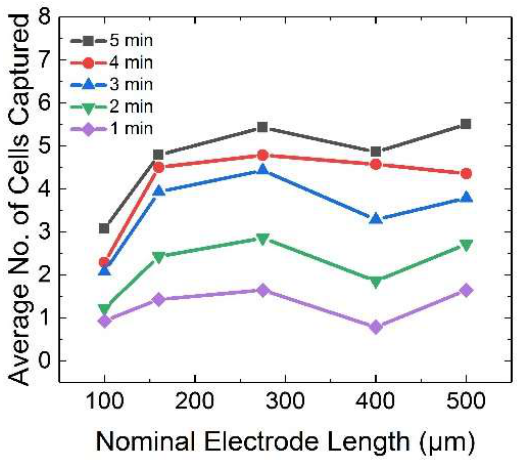
Figure 5. Plot of average cell cluster size at each BPE length at ∆ U tot = 26 V pp (70 kHz) and 200 nL / min obtained at 1 min intervals, up to t = 5 min, after initiation of driving voltage.